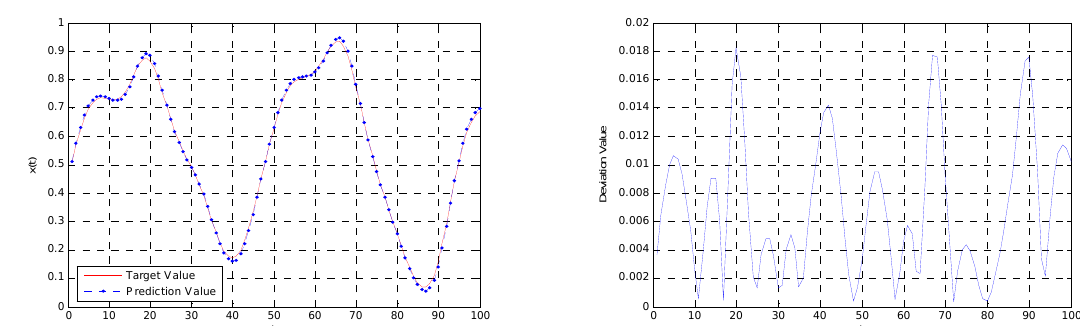
Fig. 16. The prediction value and the deviation value of Lorenz time series.